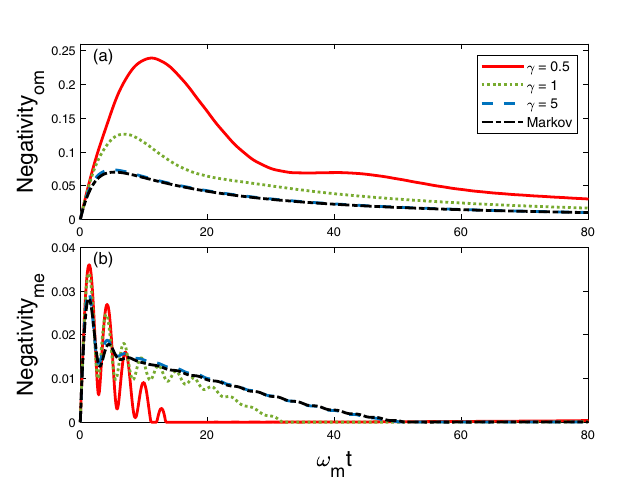
Figure 7. Dynamics of entanglement between ( a ) OM and ( b ) ME, for different γ values. Other parameters are chosen as ω o = ω e = ω m , g om = g me = 0.1 ω m , Ŵ = 1